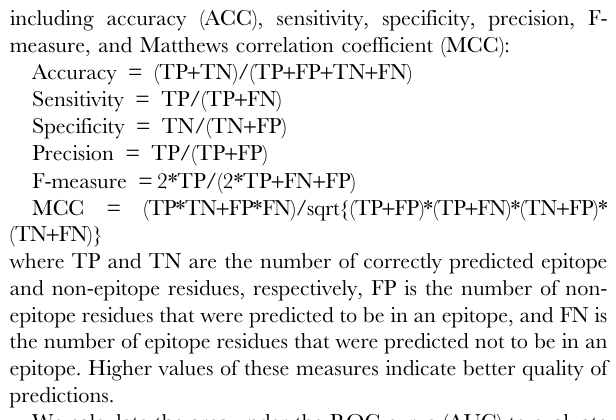
d results based on 10-fold cross validation for the SVM model ( C =8.0 and gamma =0.000977) that uses all 198 features. e results based on 10-fold cross validation for the SVM model ( C =1.0 and gamma =0.001953) that uses the selected 84 features.